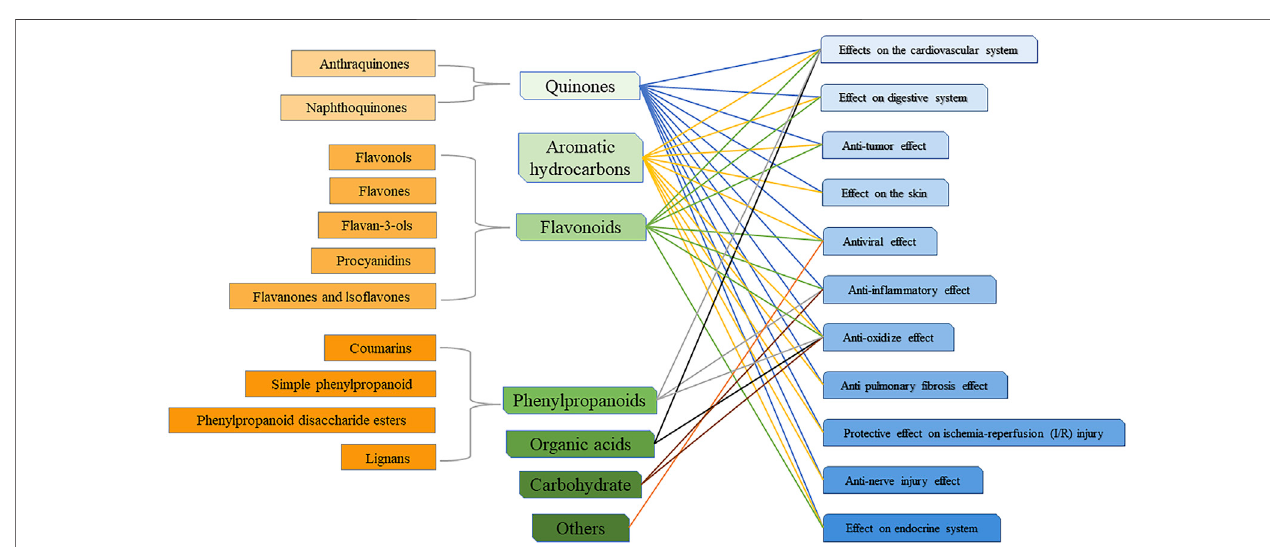
FIGURE 10 | Chemical components and biological activities of Reynoutria japonica